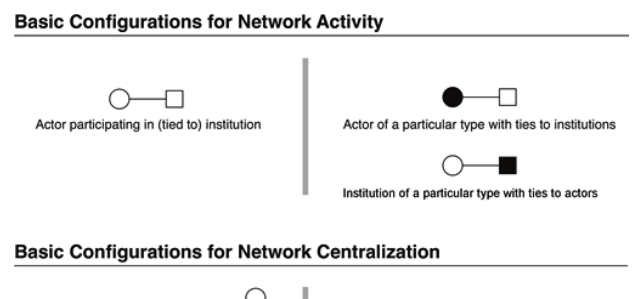
Fig. 1 . Bipartite network